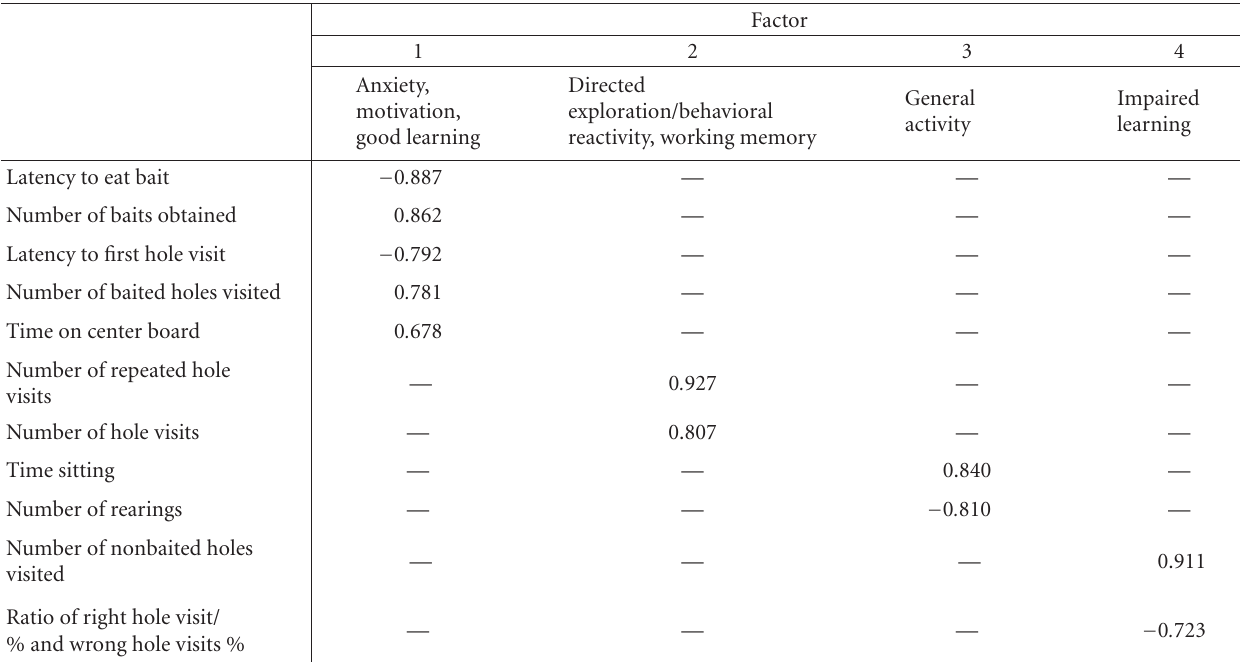
Table 2: Principal component analysis over all data, with varimax rotation and Kaiser normalization. Behavioral parameters are represented as factor loading per factor. Factor loadings with equal value are positively correlated, while loadings with opposing values are negatively correlated. Loadings < 0 . 6 are not included in this table. Eleven of the seventeen measured parameters (Table 1) have communalities > 0 . 7 and are included in the factor analysis.